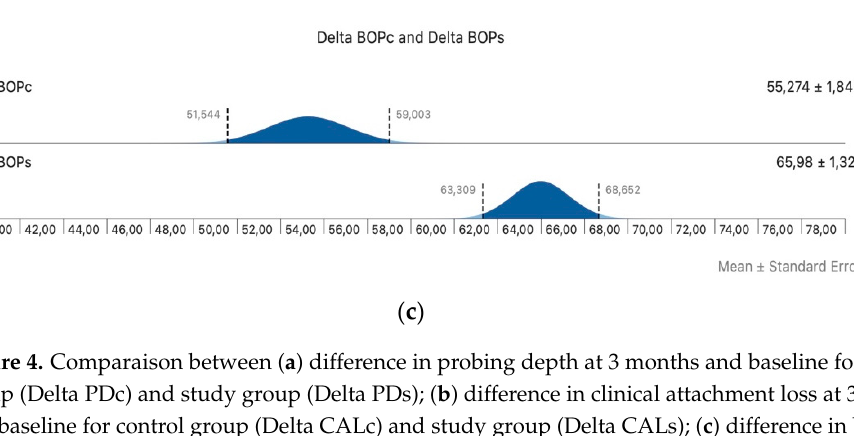
Figure 4. Comparaison between ( a ) difference in probing depth at 3 months and baseline for control group (Delta PDc) and study group (Delta PDs); ( b ) difference in clinical attachment loss at 3 months and baseline for control group (Delta CALc) and study group (Delta CALs); ( c ) difference in bleeding on probing at 3 months and baseline for control group (Delta BOPc) and study group (Delta BOPs).